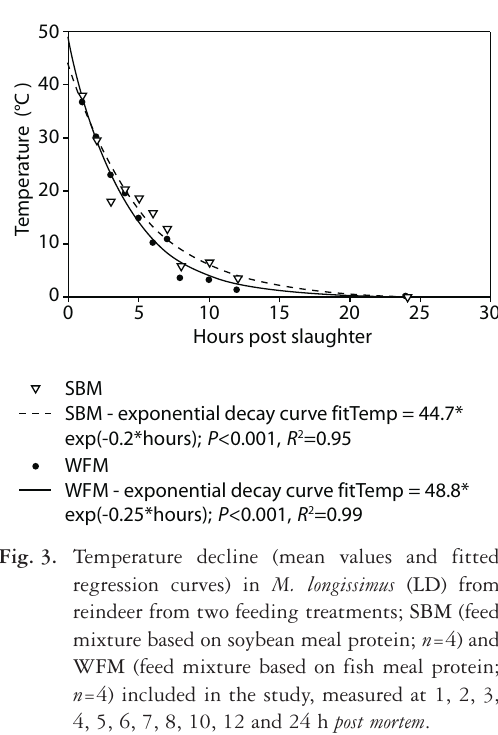
SBM SBM - exponential decay curve fitTemp = 44.7*